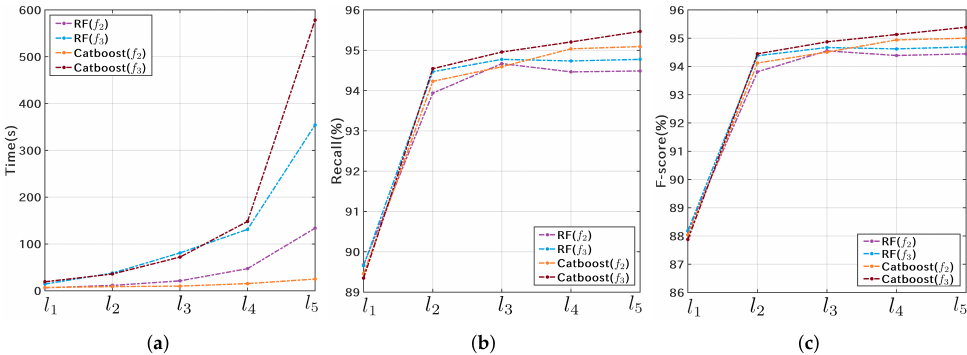
Figure 12. Cross-validation results of the RF and Catboost classifiers on the GISAID training dataset S G . ( a ) the average time cost per cross-validation; ( b ) the recall rates of the RF and Catboost classifiers 1 on data structures f 2 and f 3 ; ( c ) the F-scores of the RF and Catboost classifiers on data structures f 2 and f 3 . Table 3. The cross-validation results of the seven classifiers based on the GISAID training dataset S G